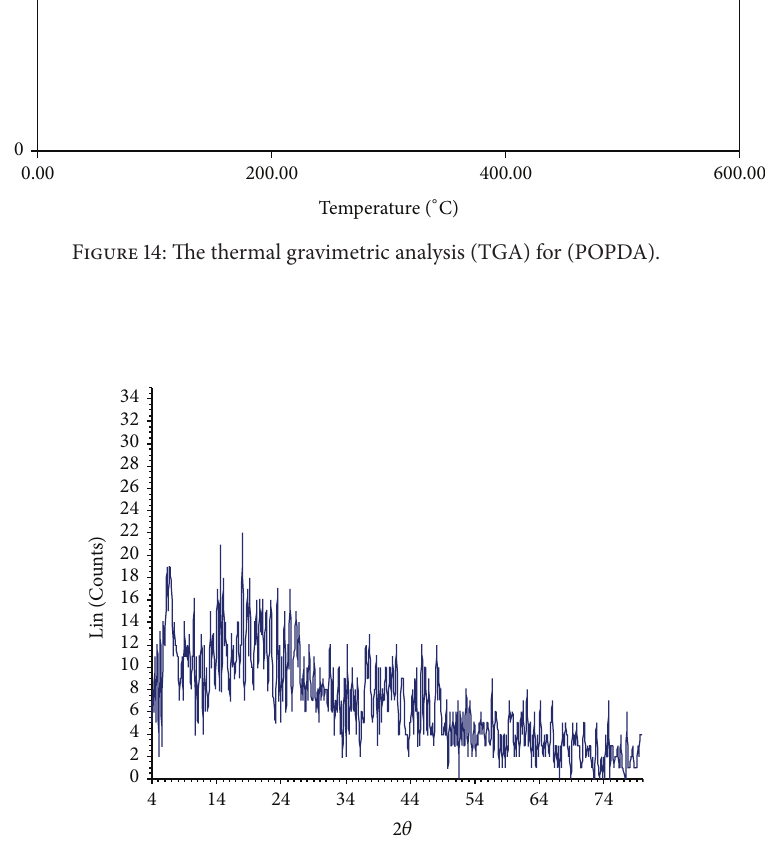
Figure 15: X-ray poly-o-phenylenediamine